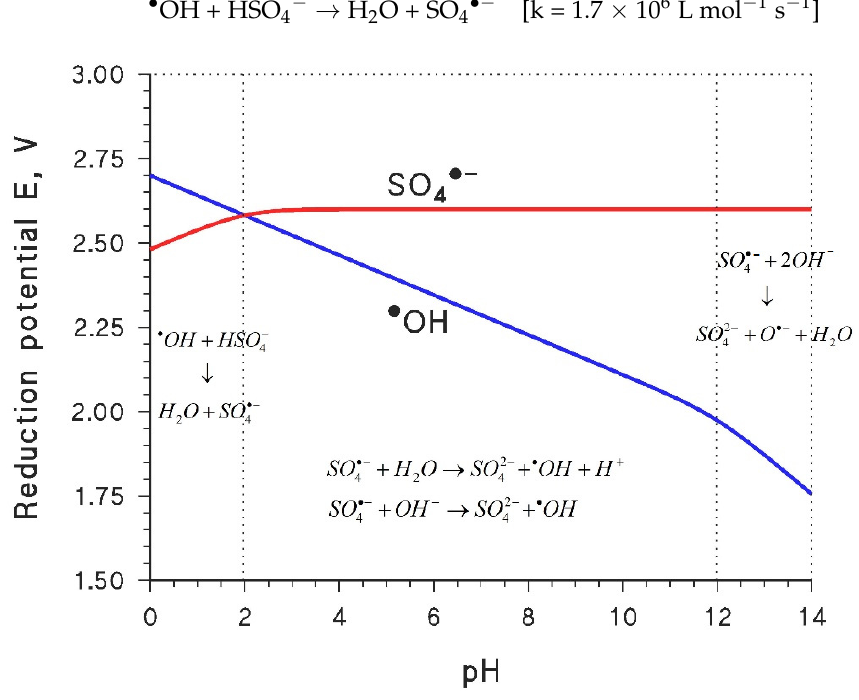
Figure 3. Trends of the reduction potentials of SO 4 •− and • OH, as a function of pH and with standard hydrogen electrode (SHE) as reference electrode. The highlighted pH values correspond to the pK a ’s of HSO 4 − (~2) and • OH (~12). The thermodynamically favored reactions involving SO 4 •− and • OH are depicted in the relevant pH